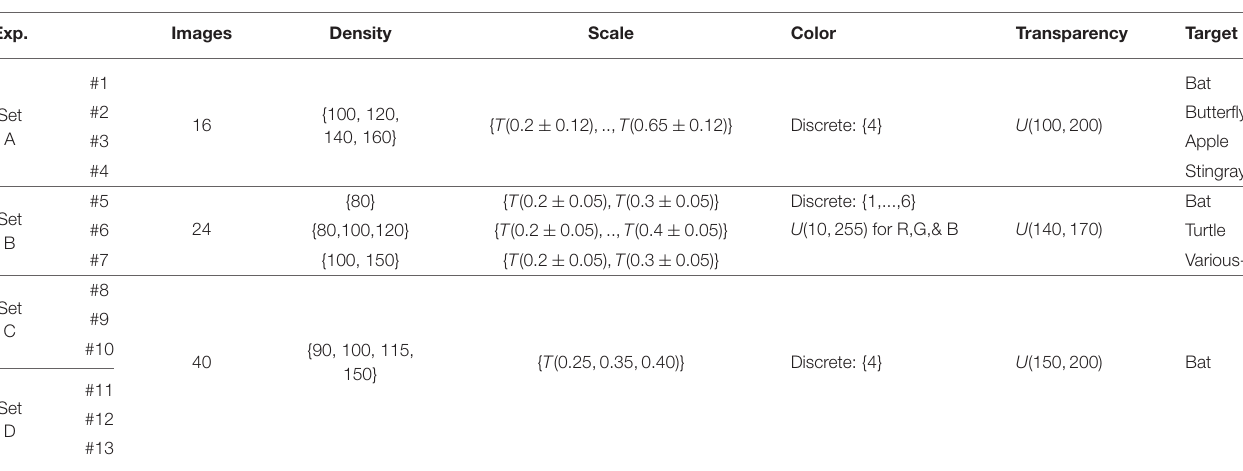
TABLE 1 | Summary of experiment image